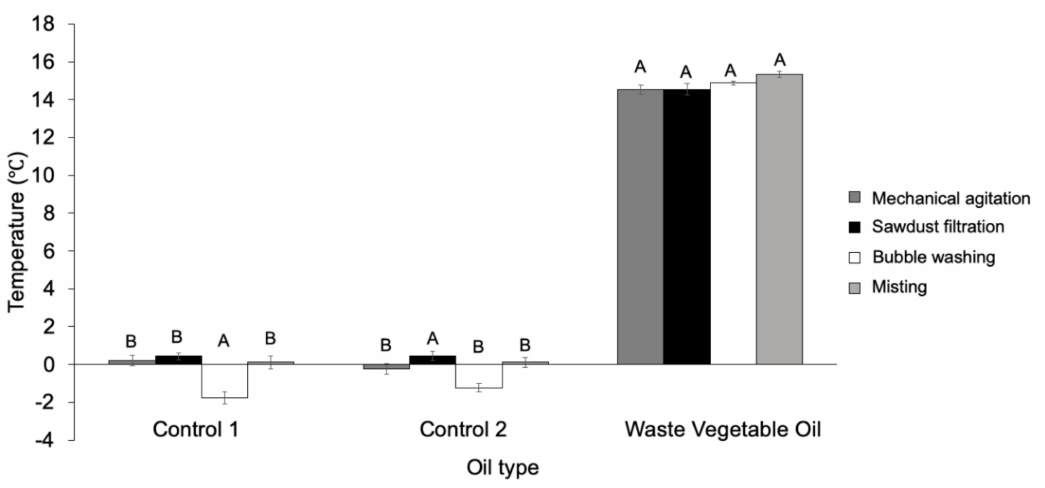
Figure 1. Cloud point.